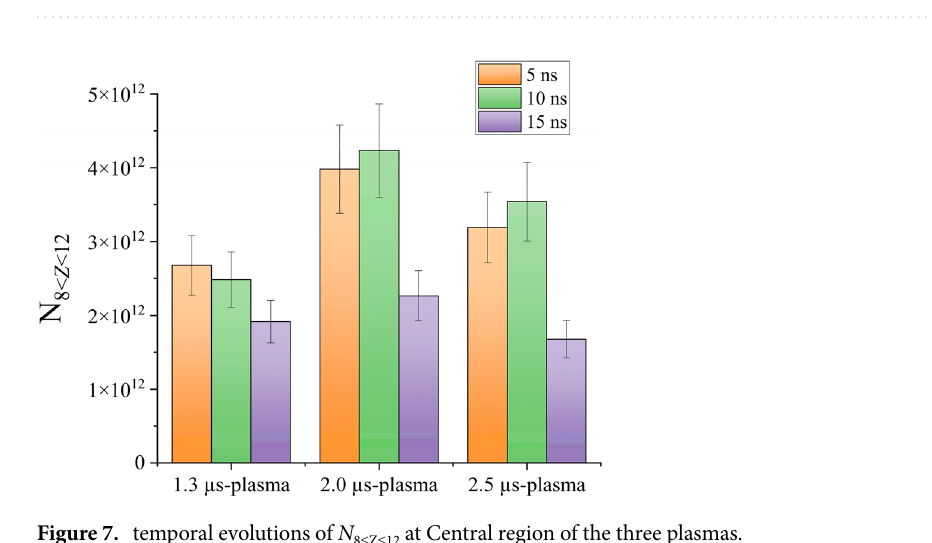
Figure 6. temporal evolutions of averaged ( a ) n i and ( b ) T e in Central region of the three plasmas.